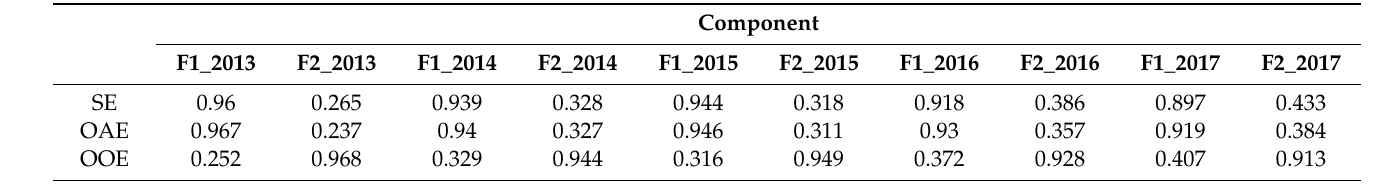
Table 5. Rotated component matrix a